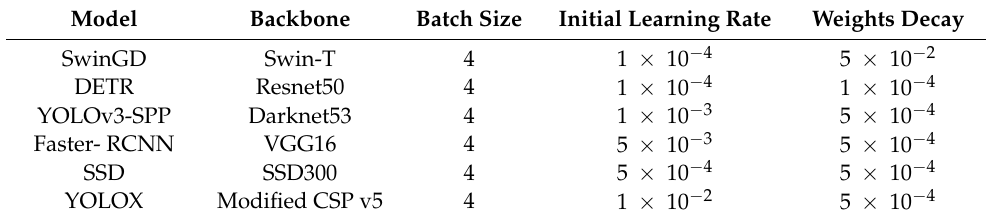
Table 1. Initialization parameters of